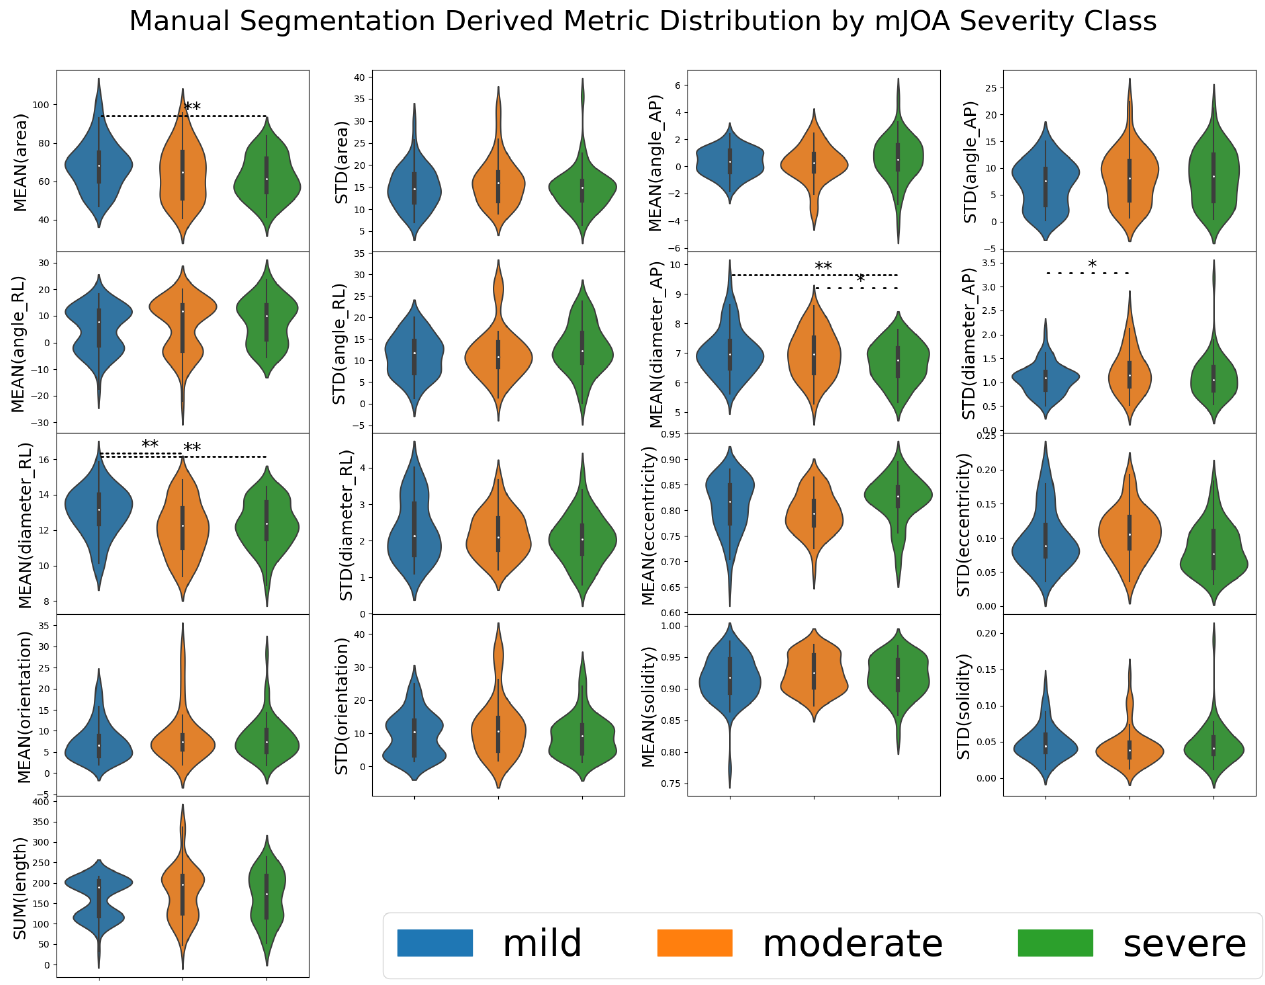
Figure 3. A violin plot of the distribution metrics extracted from manually segmented spinal cord images for 50 patients via the SCT. Each box represents one of the metrics evaluated by SCT, with the results grouped by mJOA severity classes. When the metric for one mJOA severity class was significantly different from another mJOA severity class (as determined by one-way ANOVA using SciPy’s f_oneway function returning a p -value less than 0.05), a line denoting such is present. A single * with a sparse dotted line denotes p < 0.05, ** with a tightly dotted line denotes p < 0.01. Metrics were taken from automated SCT analysis [13] of segmentations from 195 spinal cord MRI